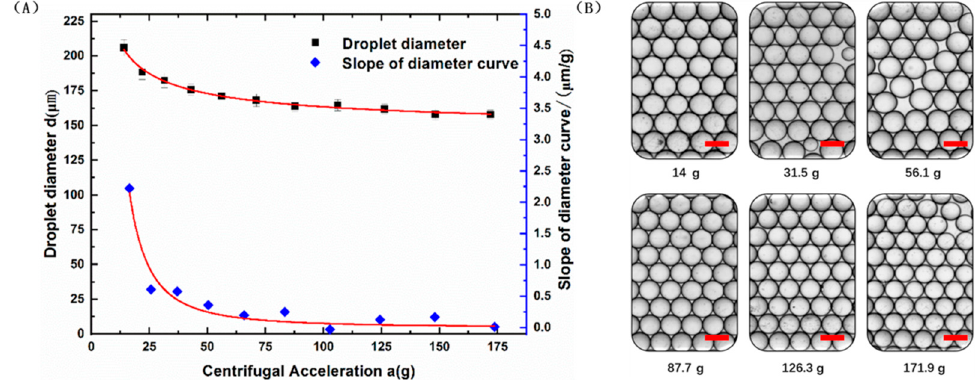
Figure 2. Experiments with different centrifugal accelerations using the CBbE method. ( A ) Experiments with different centrifugal accelerations from 14 to 171.9 g were studied, with the capillary inner diameter and tip centrifugal radius held constant ( d cin = 60 µ m, r tip = 20 mm). The slope of the diameter curve was calculated as ∆ d / ∆ a . Each data point corresponds to three independent measurements of droplet diameter. Error bars given are standard deviations (SD). ( B ) Microscope images of the produced droplets using different centrifugal accelerations. Scale bars = 200 µ m.